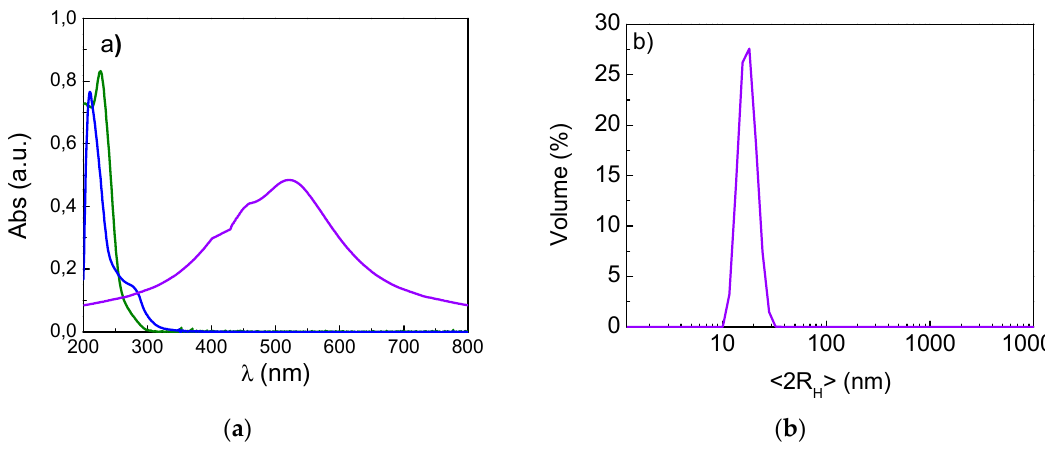
Figure 1. ( a ) UV–Vis spectrum of gold nanoparticles (AuNPs) (violet curve) and complexes A (green curve) and B (blue curve); ( b ) dynamic light scattering (DLS) measurement in water of AuNPs alone (in violet): <2R H > = 15 ± 2 nm.